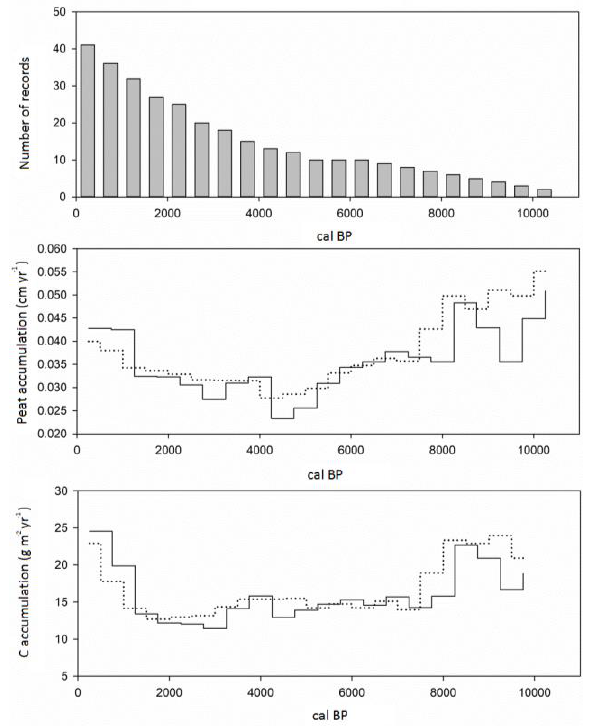
Figure 3. Peat and carbon accumulation, inferred from sites with age-depth models only. The plots show number of sites contributing (grey bars, top plot), unweighted (dotted) and weighted peat accumulation (black line, middle plot) and unweighted (dotted, bottom plot) and weighted (black, bottom plot) inferred carbon accumulation based on the re-sampling approach discussed in the